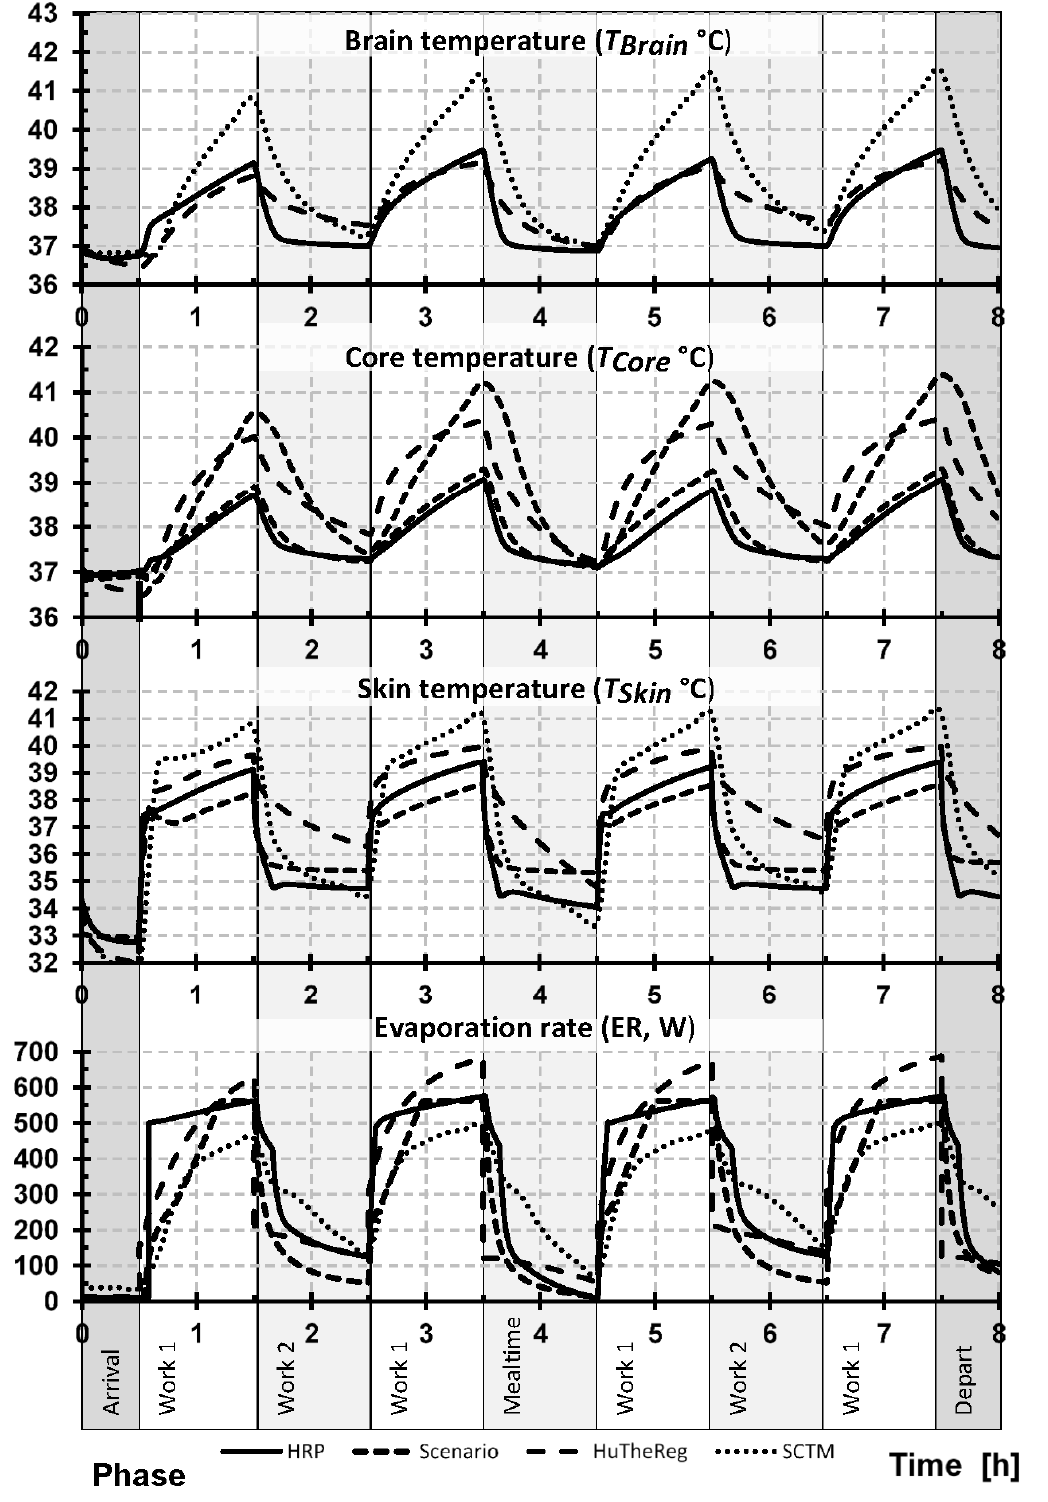
Figure 2. Predicted response pattern of brain, skin, and core body temperatures and evaporation rate during the entire work shift for extremely hot conditions (G_14). Note: HRP, health-risk prediction (HRP) model; HuTheReg, human thermal regulation model (HuTheReg); SCTM, six-cylinder thermoregulatory model.